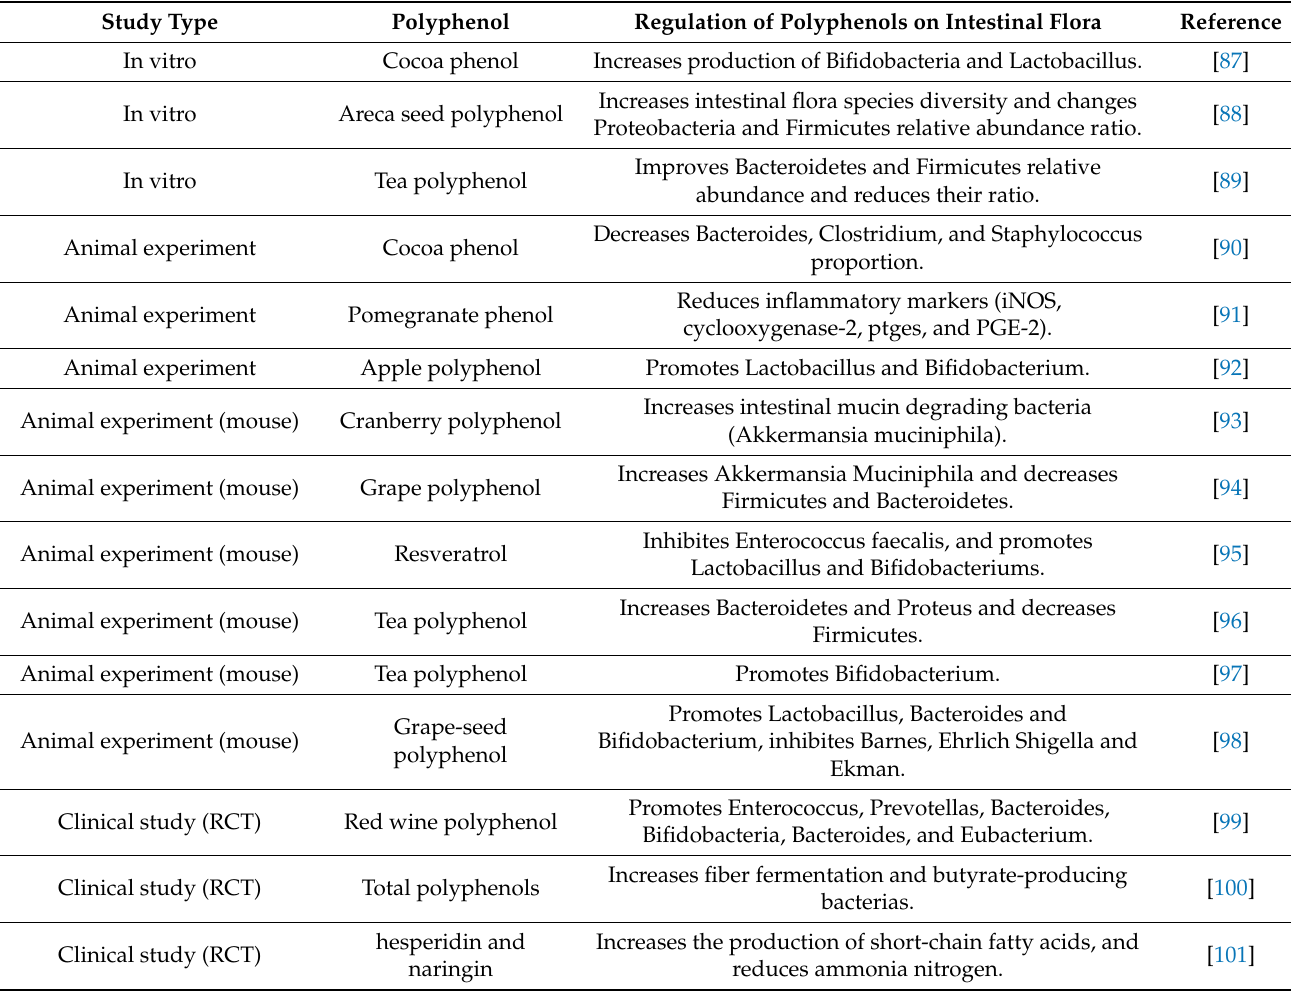
Table 2. The regulation of polyphenols and polyphenol-rich extracts on intestinal